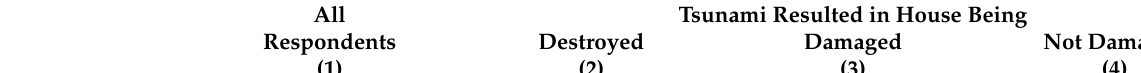
Table 2. Receipt of housing aid and tsunami-related housing